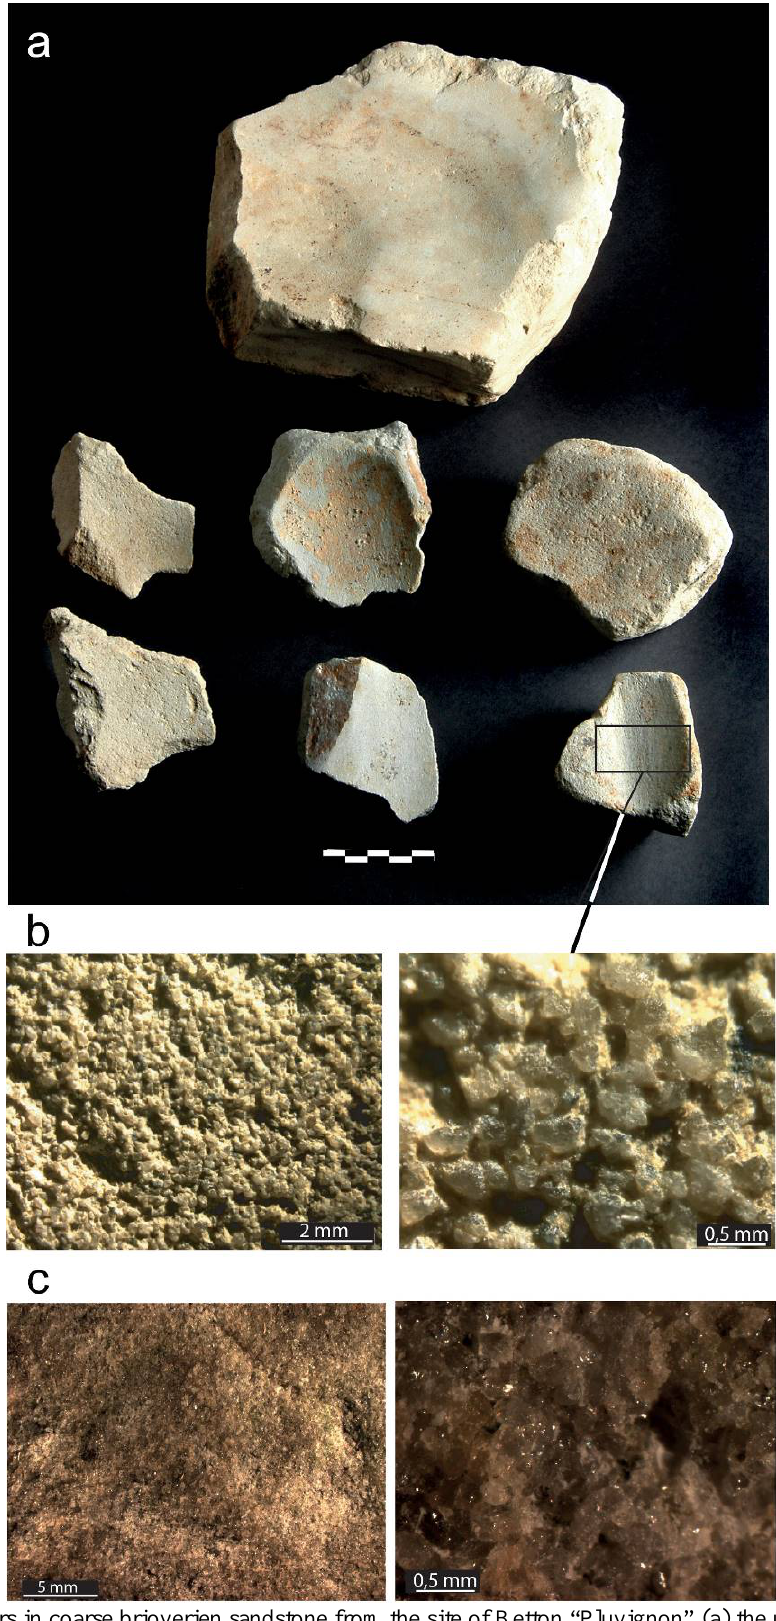
Figure 7. Abraders in coarse brioverien sandstone from the site of Betton “Pluvignon” (a) the use-wear observed on all these tools (b) are comparable to experimental surfaces used for fresh bone tool shaping by abrasion during one hour. Note in both cases the intermediate rate of levelling, well individualized grains, and slightly altered to microfractured surfaces